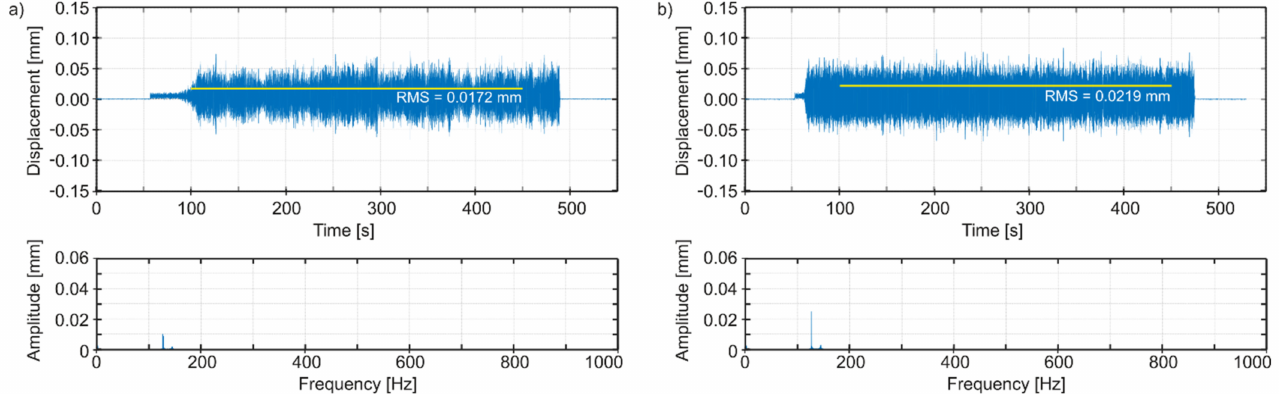
Figure 12. Simulated vibrations of the edge tip in the cutting speed direction: ( a ) the best spindle speed n = 115 rpm, ( b ) adverse spindle speed n = 125